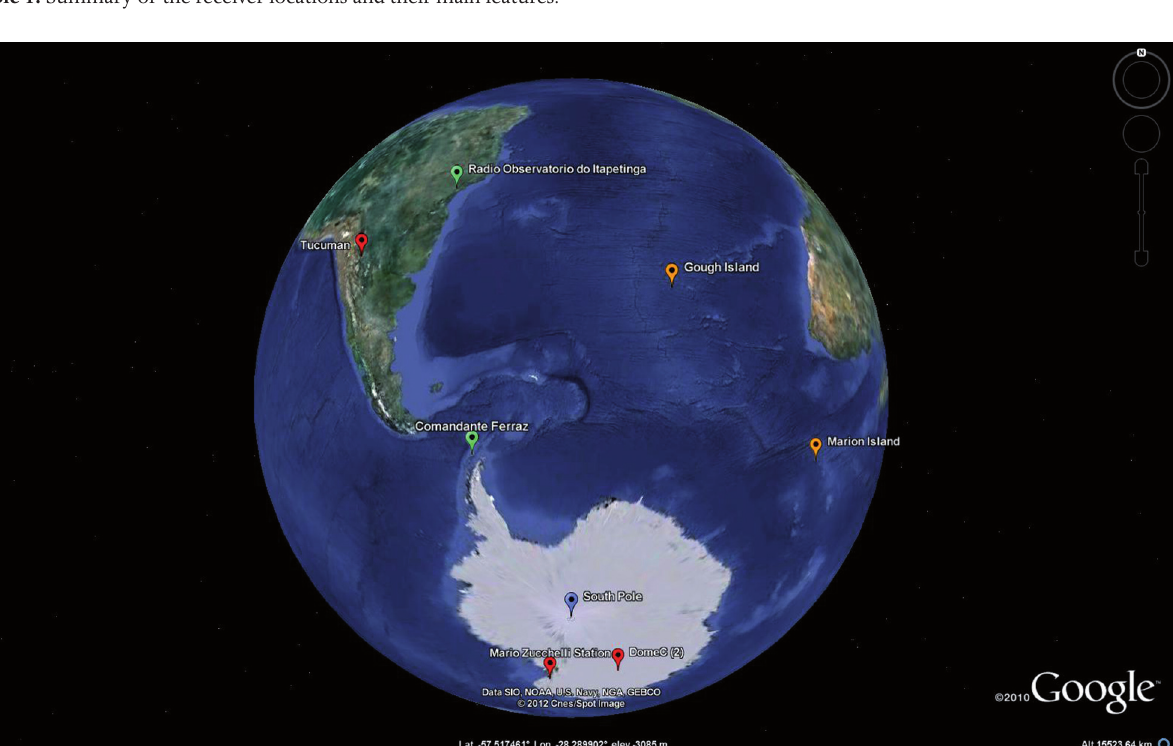
Table 1. Summary of the receiver locations and their main features.